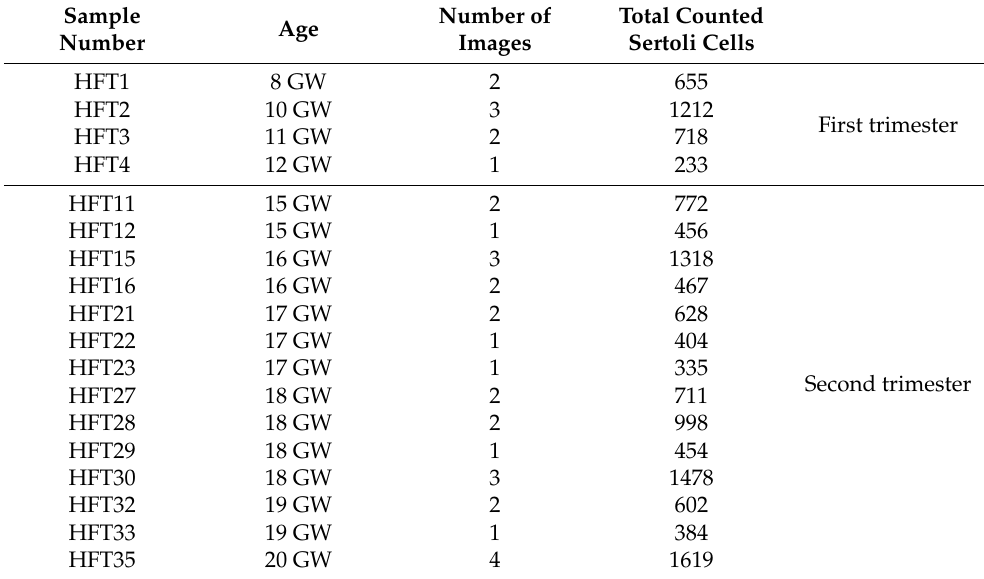
Table 2. Details of human fetal testis tissue used for semi-quantification of desmin expression in SOX-9 positive cells.